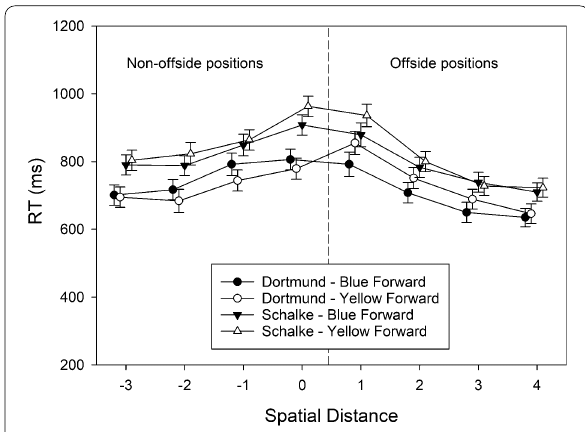
Fig. 4 The RTs of correct offside judgments observed in Experiment 1, plotted as a function of spatial distance (between forward and defender), participants’ team preference (Dortmund vs. Schalke), and shirt color of the attacking team (blue vs. yellow). Error bars represent standard errors between participants. For each level of spatial distance, data points are jittered to increase